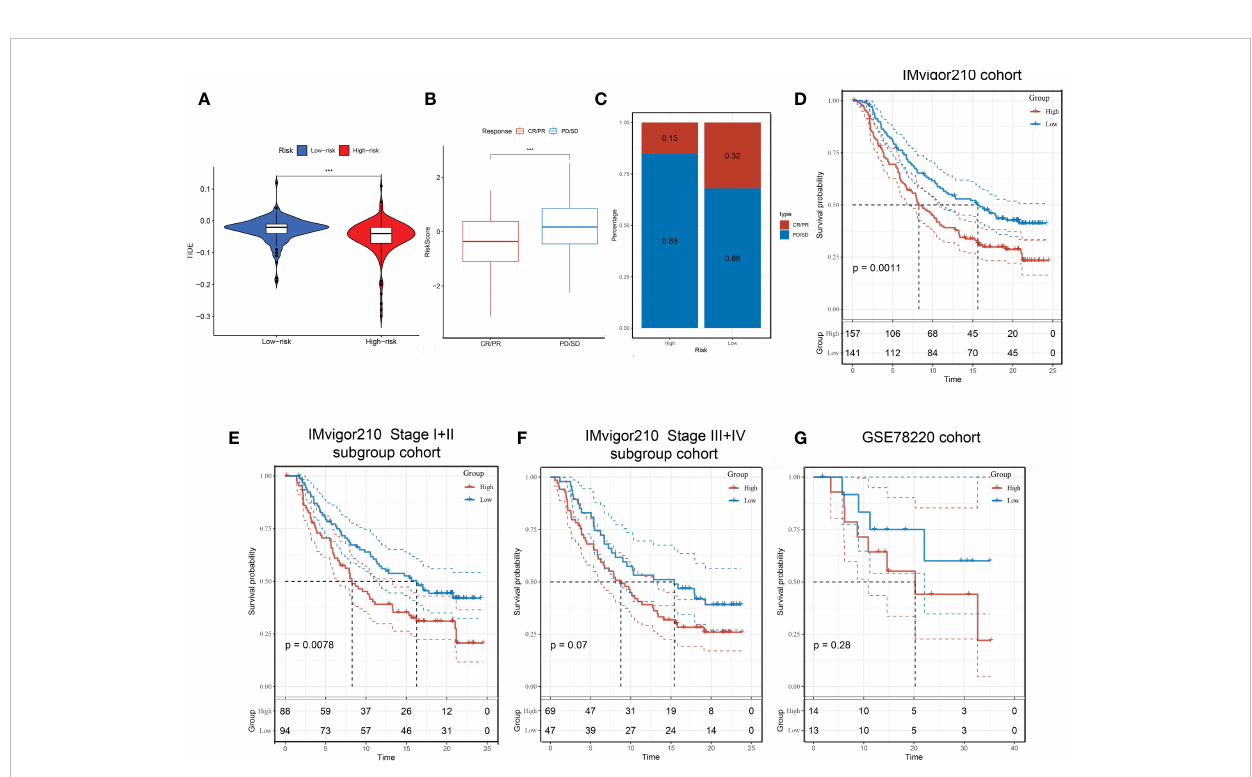
FIGURE 9 Immunotherapeutic responses in high- and low-risk groups with HCC. (A) Correlation between risk score and immunotherapy response. (B) In the IMvigor210 cohort, patients ’ prognostic was related to Tex-related risk score. (C) Distribution of immunotherapy responses among high- and low- risk groups in the IMvigor210 cohort. (D-F) Prognostic differences among risk score groups in the IMvigor210 cohort (D) , Stage I+II subgroup (E) , and Stage III+IV subgroup (F) . (G) prognostic differences between high- and low-risk groups in the GSE78220